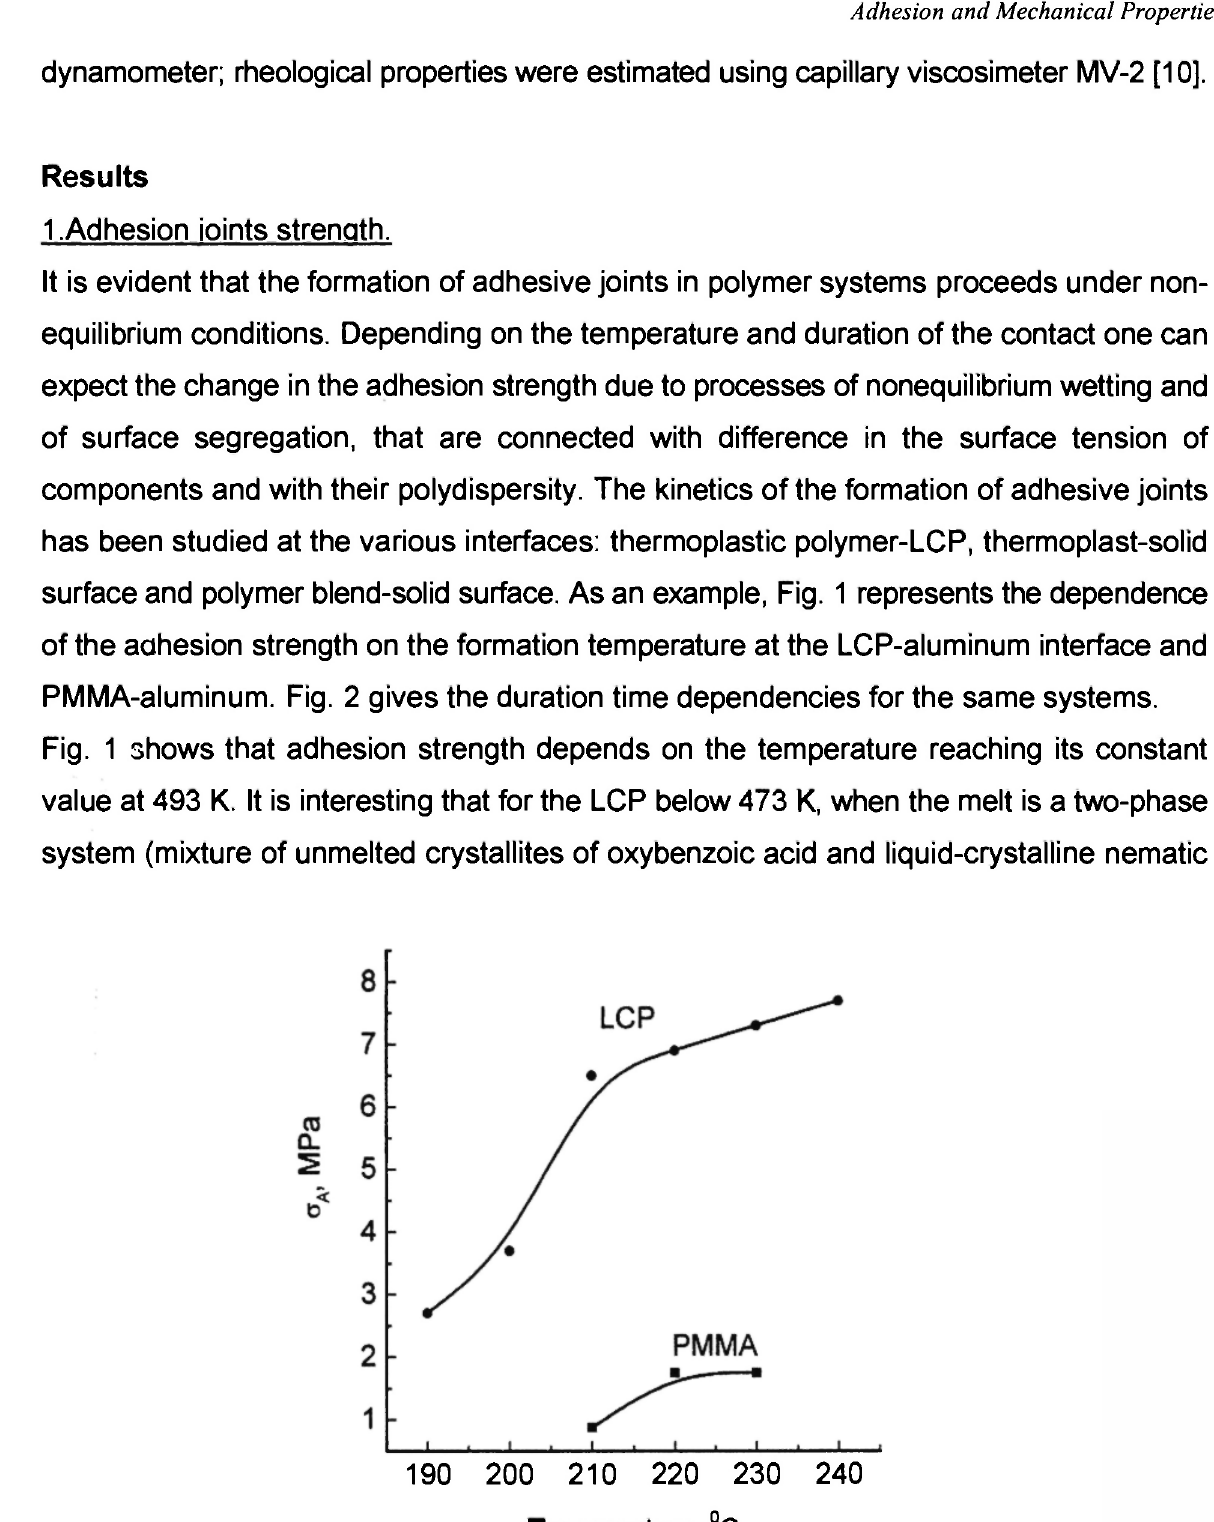
Fig. 1. Dependence of o on temperature of the adhesion joint formation for LCP and Al and A PMMA and